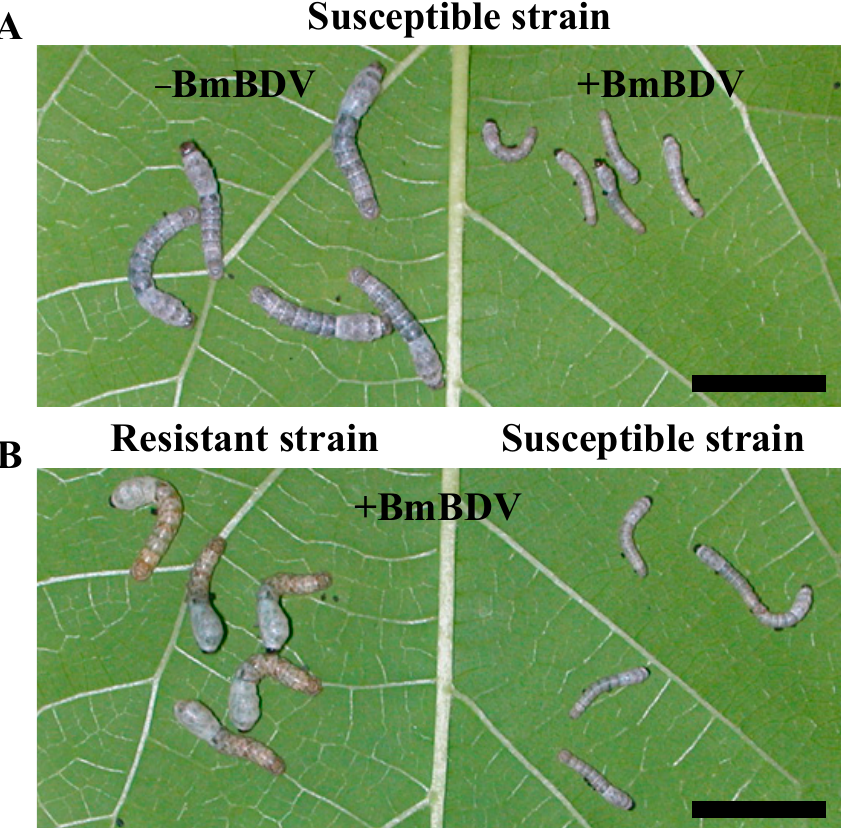
Figure 1. The effect of BmBDV infection on silkworm larvae. ( A ) Comparison of the BmBDV uninfected and infected susceptible silkworm strain at nine days post infection (DPI). Left and right show the virus-uninfected and virus-infected silkworms, respectively. ( B ) Comparison of BmBDV infected resistant and susceptible silkworm strains at nine DPI. Both are the virus-infected silkworm. Scale bar, 10 mm.